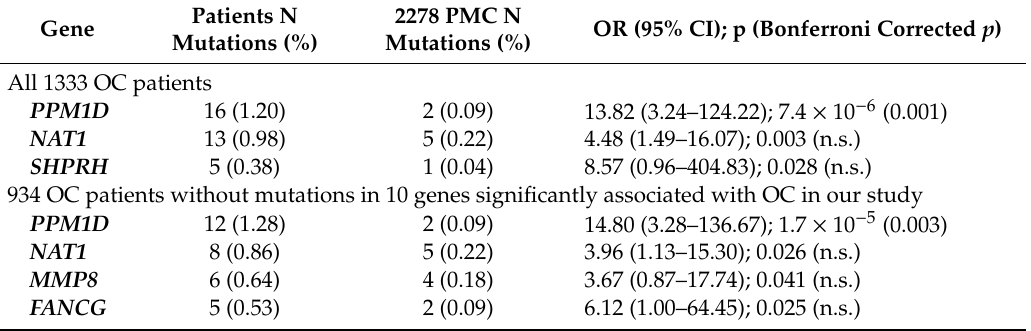
Table 2. Additional 201 analyzed genes significantly associated with OC risk in the group of all OC patients and in a subgroup of 934 patients without mutations in 10 established OC predisposition